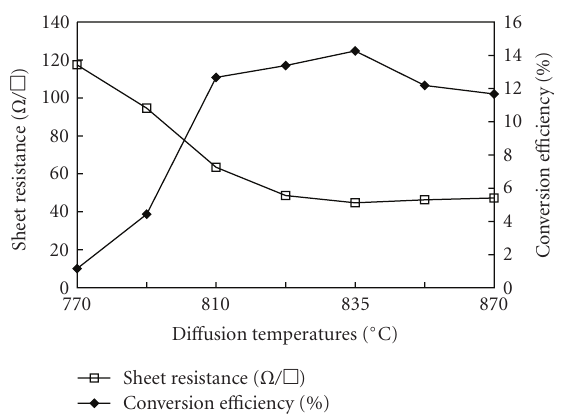
Figure 3: The sheet resistance (in Ω / (cid:2) ) and conversion e ffi ciency (in %) with respect to di ff erent temperatures (from 770 ◦ C to 900 ◦ C) of the solar-cell prototypes with and without drive-in di ff usion processes.